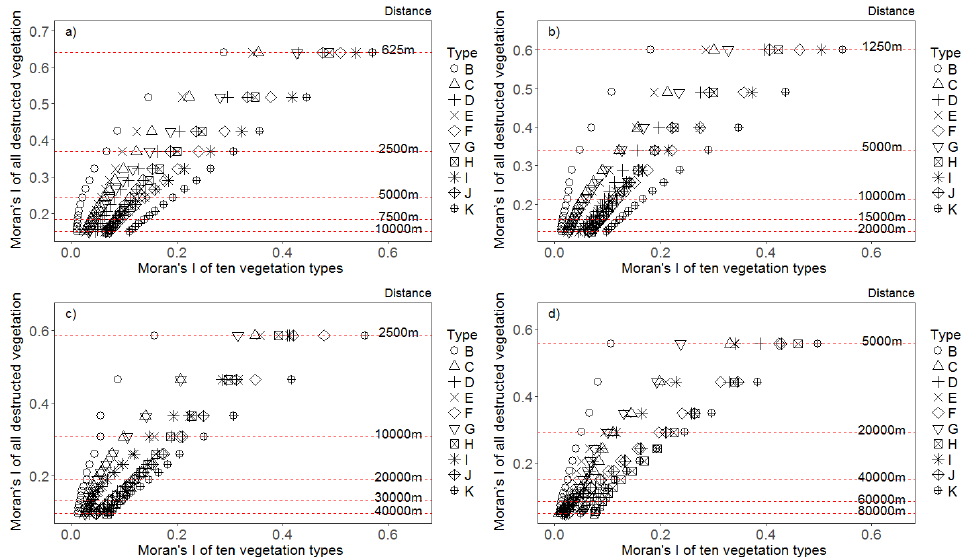
Figure 3. The relationships between the correlograms of the Moran’s I of ten vegetation types and those of all the destructed vegetation at four different aggregation levels including ( a ) the 1 × 1 aggregation level, ( b ) the 2 × 2 aggregation level, ( c ) the 4 × 4 aggregation level, and ( d ) the 8 × 8 aggregation level. The points in black are significant ( P < 0.001). The vegetation type abbreviations are defined in Table